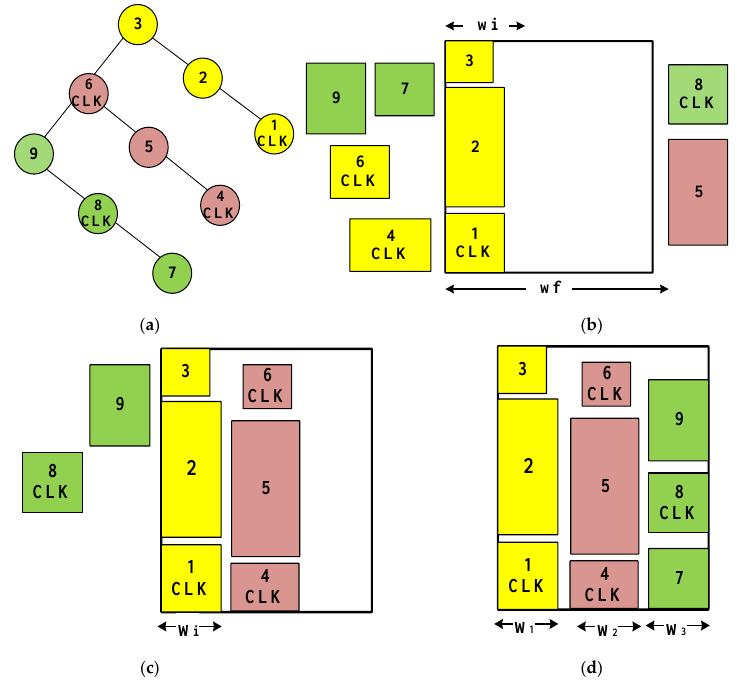
Figure 2. Placement process after implementation of proposed methodology. ( a ) tree structure; ( b ) placement of modules inside the core area of the chip 1; ( c ) placement of modules inside the core area of the chip 2; ( d ) placement of modules inside the core area of the chip 3.